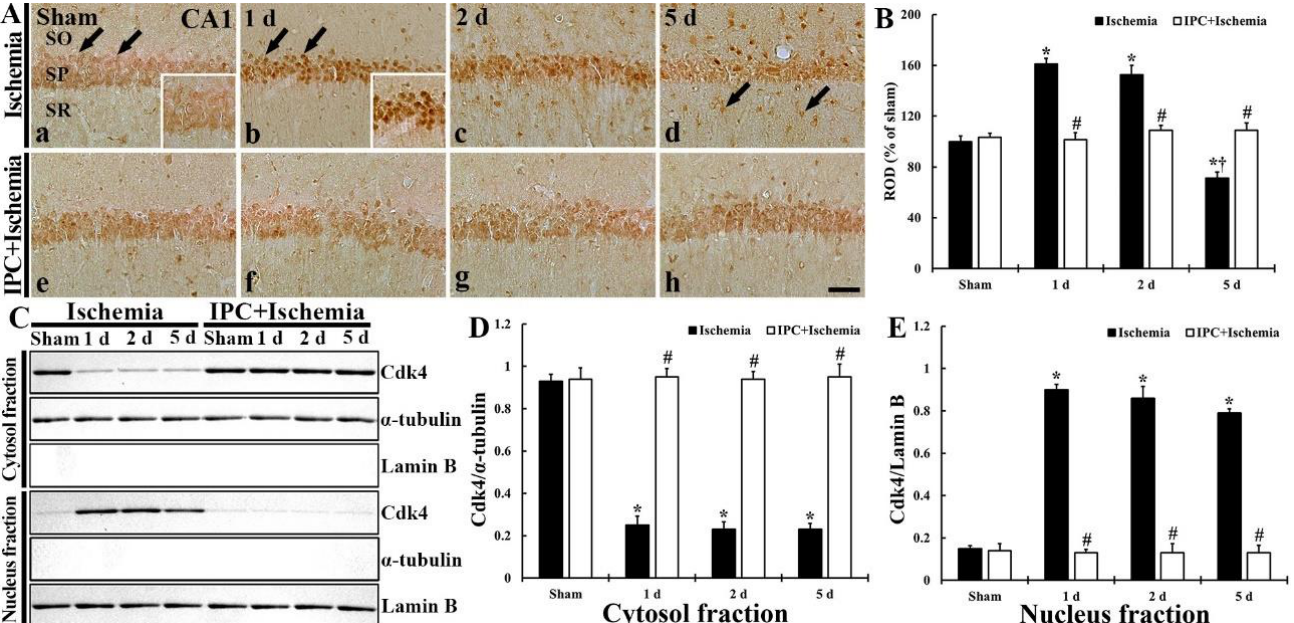
Figure 4. ( A ) Immunostaining of cdk4 in CA1 of the TI (upper column) and IPC+TI (lower column) groups at sham (a,e), 1 day (b,f), 2 days (c,g), and 5 days (d,h) after TI. Cdk4 immunoreactivity detected in the sham group is mainly found in the cytoplasm (arrows in Aa) of the pyramidal cells. In the TI group, Cdk4 immunoreactivity in the pyramidal cells is translocated into their nuclei (arrows in Ab) after TI, showing that, at 5 days, Cdk4 immunoreactivity is low in the pyramidal cells and newly shown in non-pyramidal cells (arrows in Ad). In the IPC+sham and IPC+TI groups, cdk4 immunoreactivity in the pyramidal cells is similar to that shown in the sham group. Scale bar = 50 µm. ( B ) ROD graph of cdk4 immunoreactivity in CA1 pyramidal cells. ROD was calibrated as percent (sham group, 100%). The bars represent means ± SD ( n = 7, * p < 0.05 versus sham; # p < 0.05 versus TI group; † p < 0.05 versus prior time point of each group). ( C ) Western blot of cdk4 (30 kDa) protein level in CA1 of the TI and IPC+TI groups at sham, 1 day, 2 days, and 5 days after TI. α -tubulin and lamin B are used for standardizing cytosol and nucleus protein loading. ( D , E ) Relative band intensity of cdk4 level in cytosol ( D ) and nucleus ( E ). The bars represent means ± SD ( n = 7, * p < 0.05 versus sham; # p < 0.05 versus TI group).